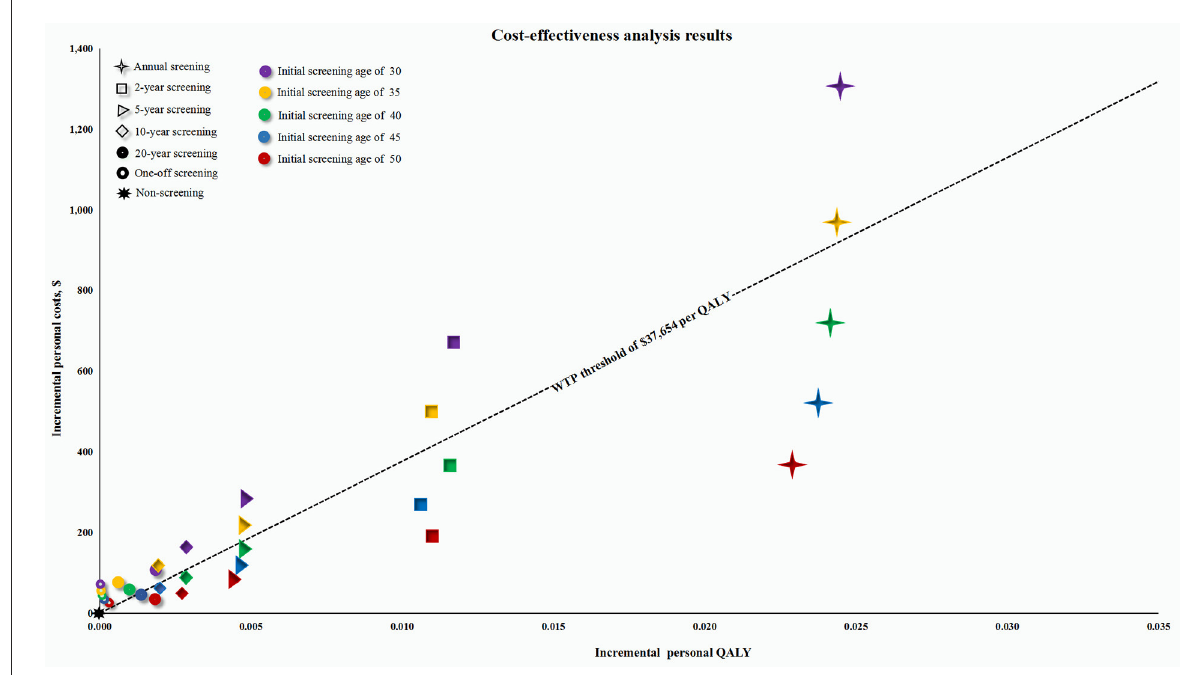
FIGURE2 Cost-effectiveness plane for all screening strategies in the male cohort. QALY, quality-adjusted life-year; WTP, willingness-to-pay. The screening strategies represented by the point below the WTP threshold of $37,654 per QALY are considered to be cost-effective; Otherwise they are not